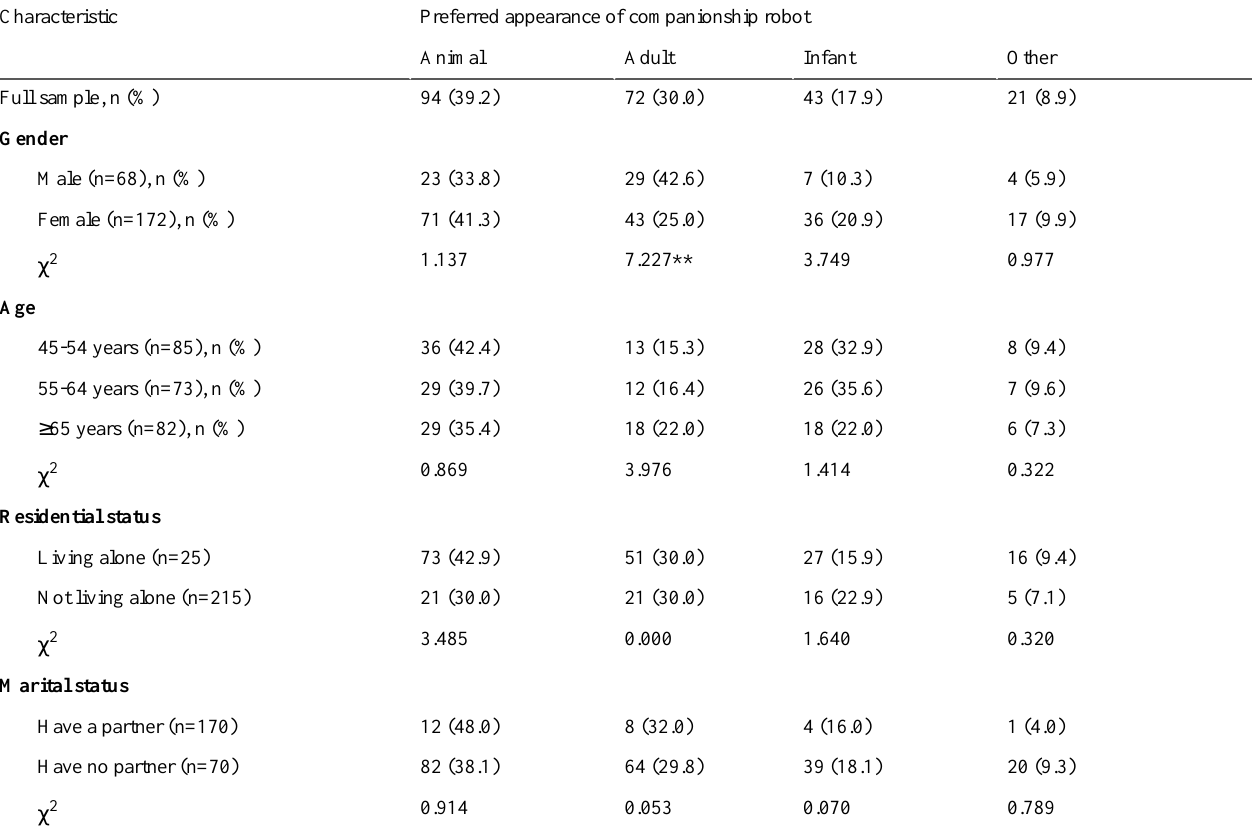
Table 4. Analysis of the preference of the middle-aged and older adults for the appearance of the companionship robot (N=240). Preferred appearance of companionship robotCharacteristic